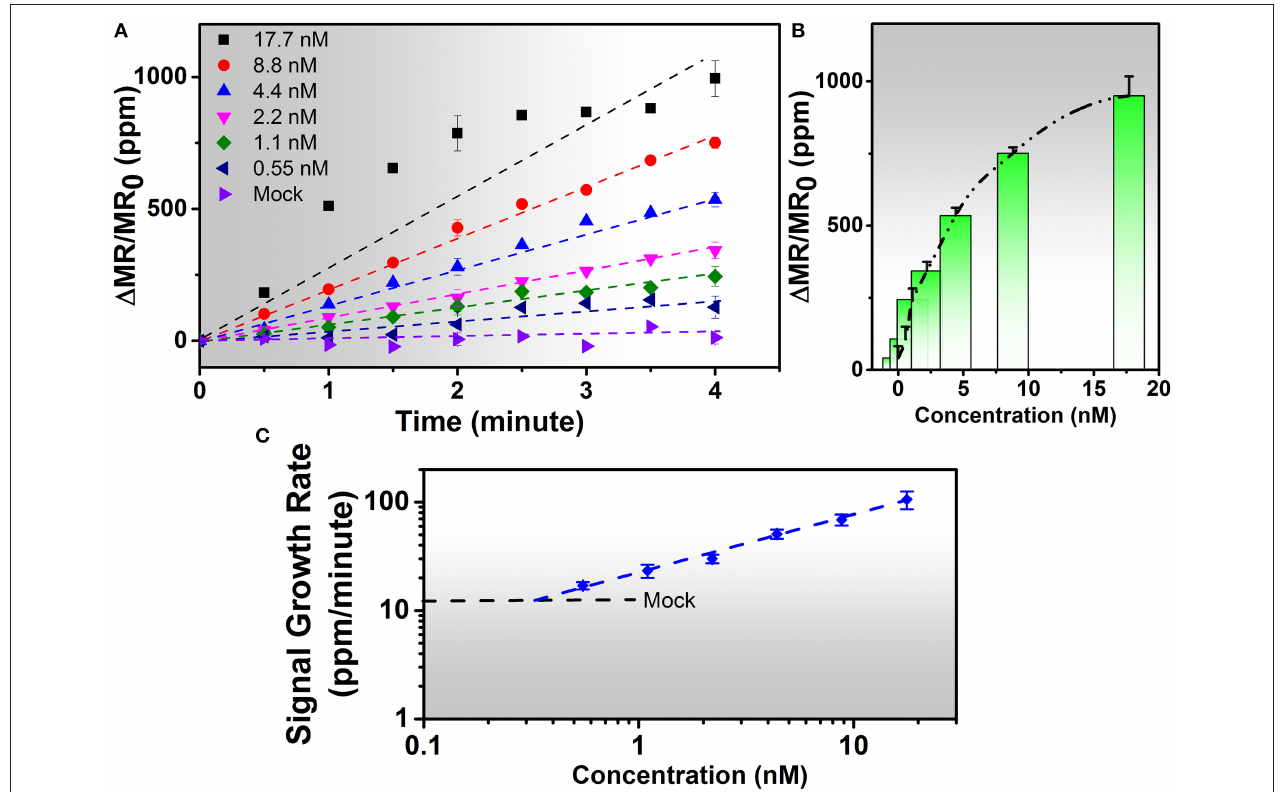
FIGURE 3 | (A) Real-time binding curves of different concentrations of 20 µ L of IAV nucleoprotein samples measured using the Z-Lab handheld device over a 4-min measurement period. As is observed from figure (A) , the sensor signal increases linearly during the 4-min measurement period except for 17.7nM sample. (B) Averaged signals from (A) . The y-axis is denoted as changes in magnetoresistance (MR) normalized to initial MR in ppm (parts per million). (C) Calibration curves of IAV nucleoprotein bioassays. The mock level is plotted as a dashed line. Signal slopes were obtained by linear regression from t = 0 to t = 4min to quantify the concentrations of target analytes from biological samples. Error bars in (A,B) indicate standard deviations of magnetoresistance signals from multiple GMR biosensors. Error bars in (C) indicate standard deviations of signal growth rates from multiple GMR biosensors during the time period of 4min.